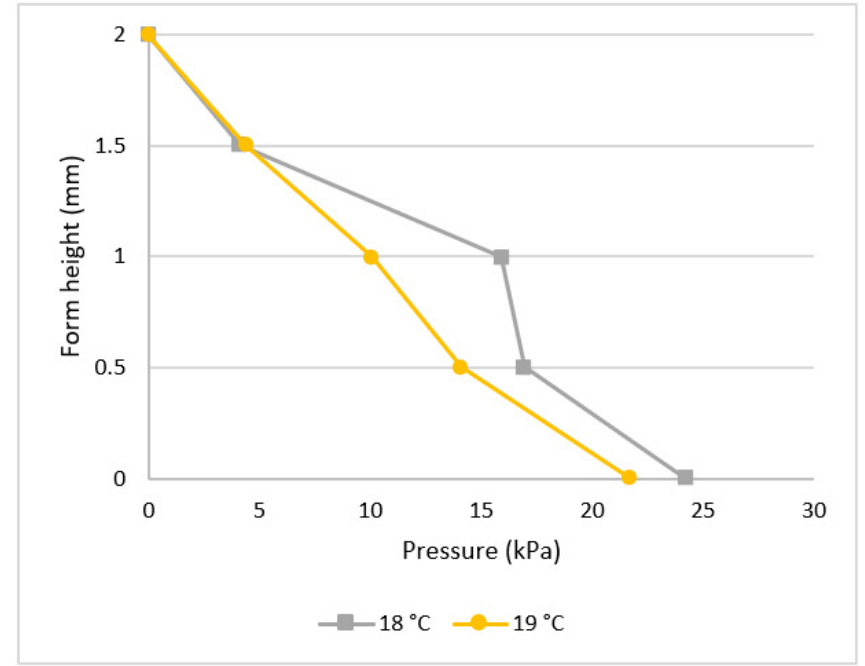
Figure 10. Effect of concrete temperature on form pressure.